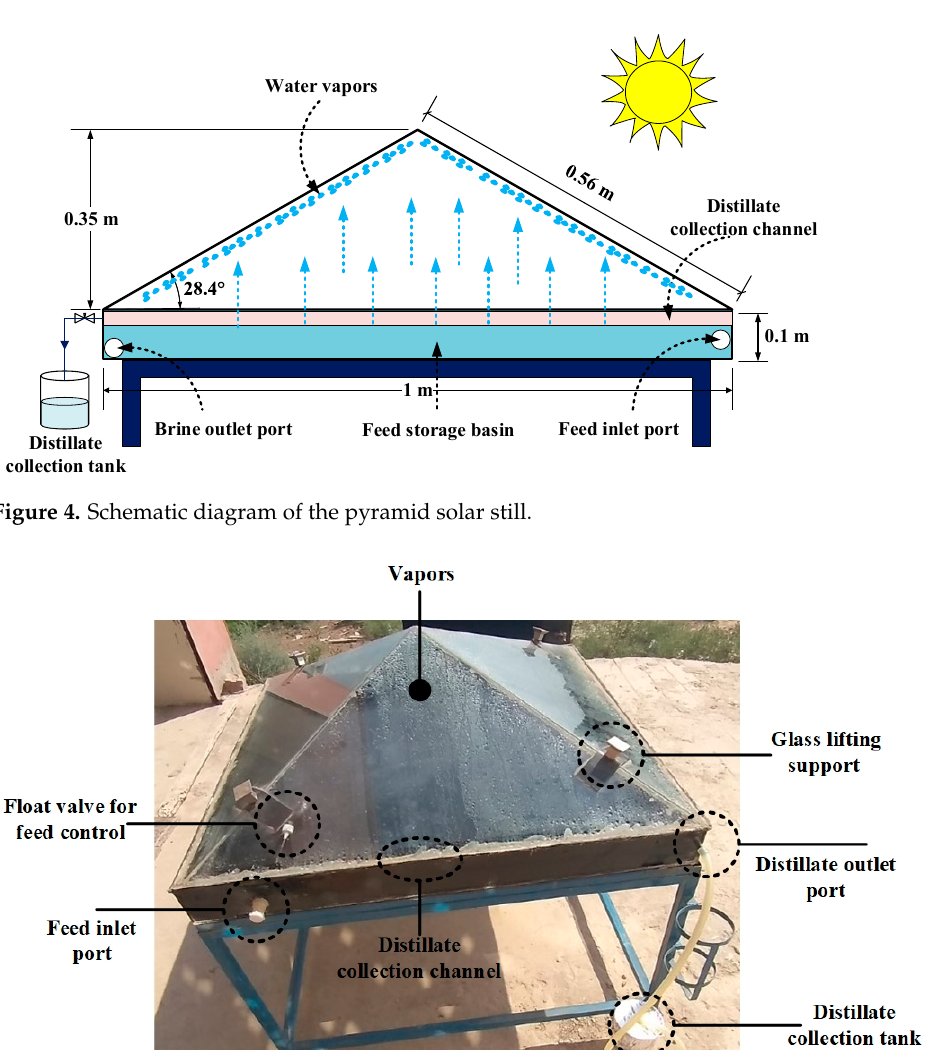
Figure 3. Single slope solar still experimental setup.